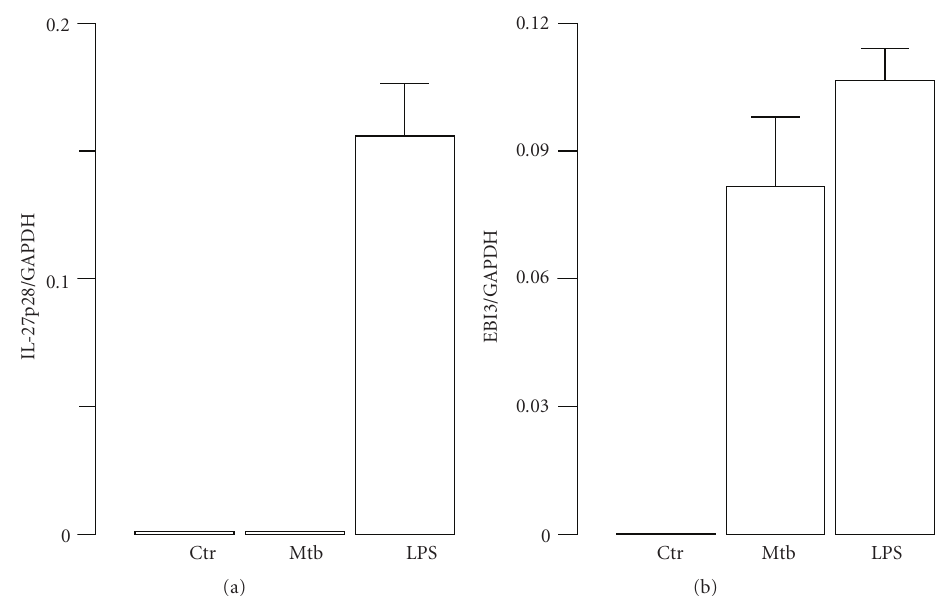
Figure 2: Expression of IL-27 subunits in Mtb-infected or LPS-treated human monocytes. RNA was extracted from monocytes infected with Mtb (MOI = 1) or LPS (1 μ g/ml) for 8hr. Real-time reverse transcription-polymerase chain reaction was performed to measure the expression of IL-27p28 and EBI3 subunits. The results are shown as a ratio to the GAPDH level and represent the mean ± SE of triplicate values. The results shown are from one out of three experiments performed with di ff erent donors that yielded similar